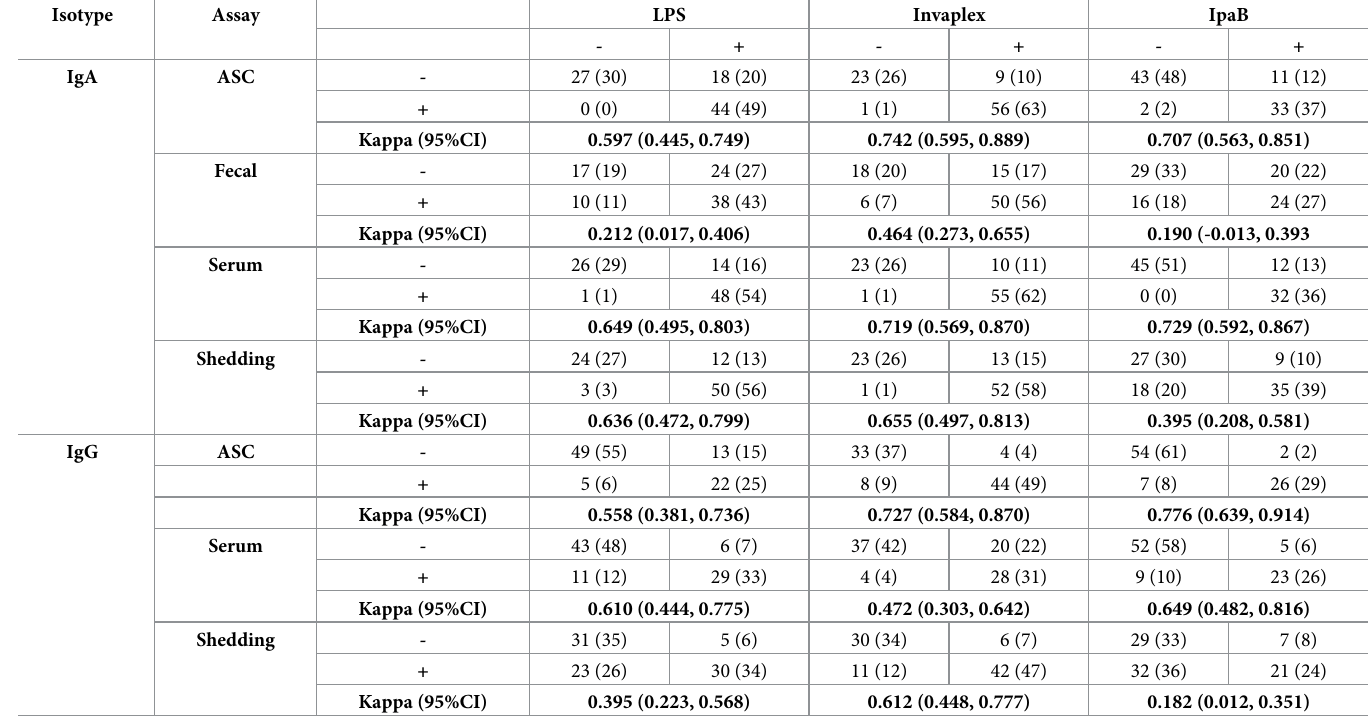
Table 3. Agreement of ALS responders with other mucosal and serologic responders and fecal shedding (Kappa statistic; 95% Cl). Isotype